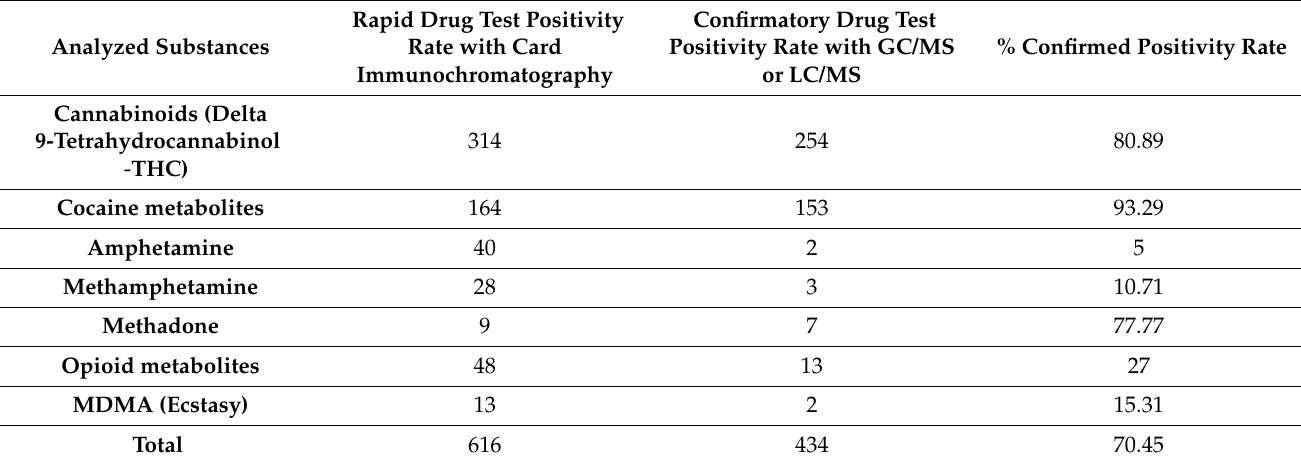
Table 5. Positivity detected in the level 1 tests (screening and confirmatory analysis) divided by analyzed